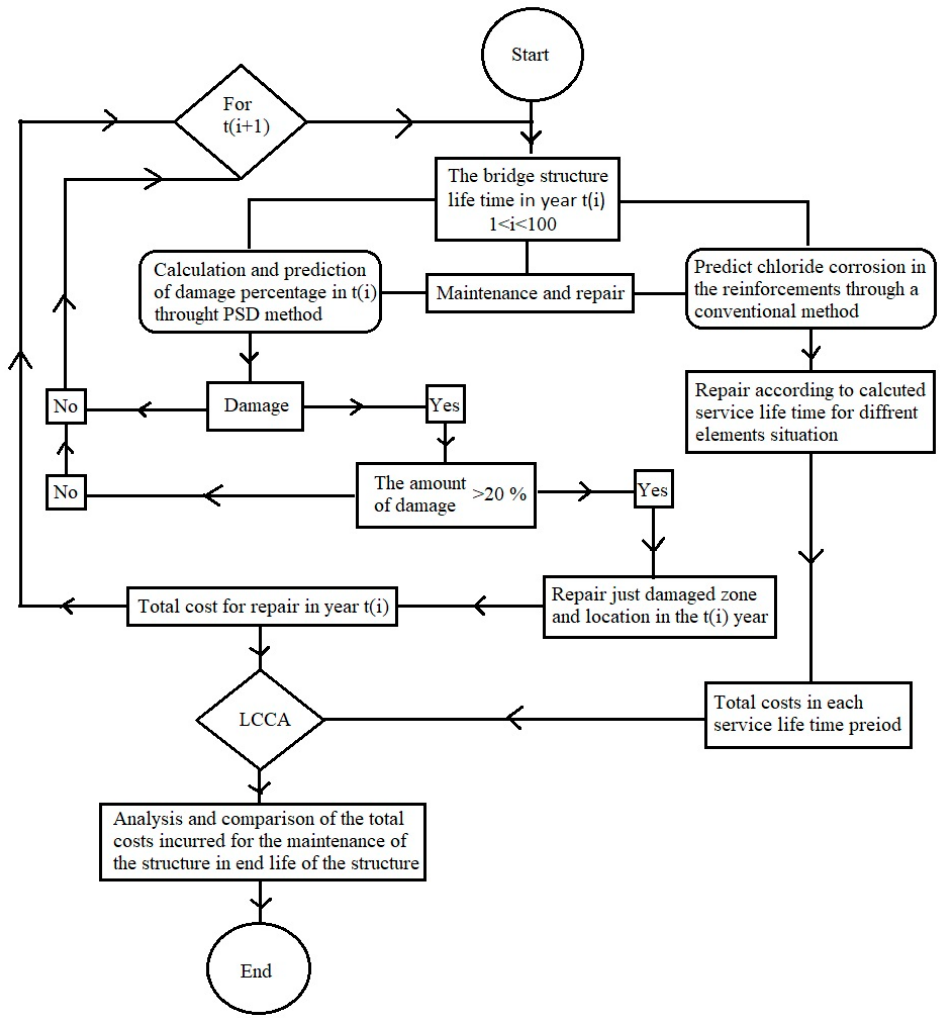
Figure 6. The summary of analysis and calculation processes performed on the numerical model of the Arosa bridge.